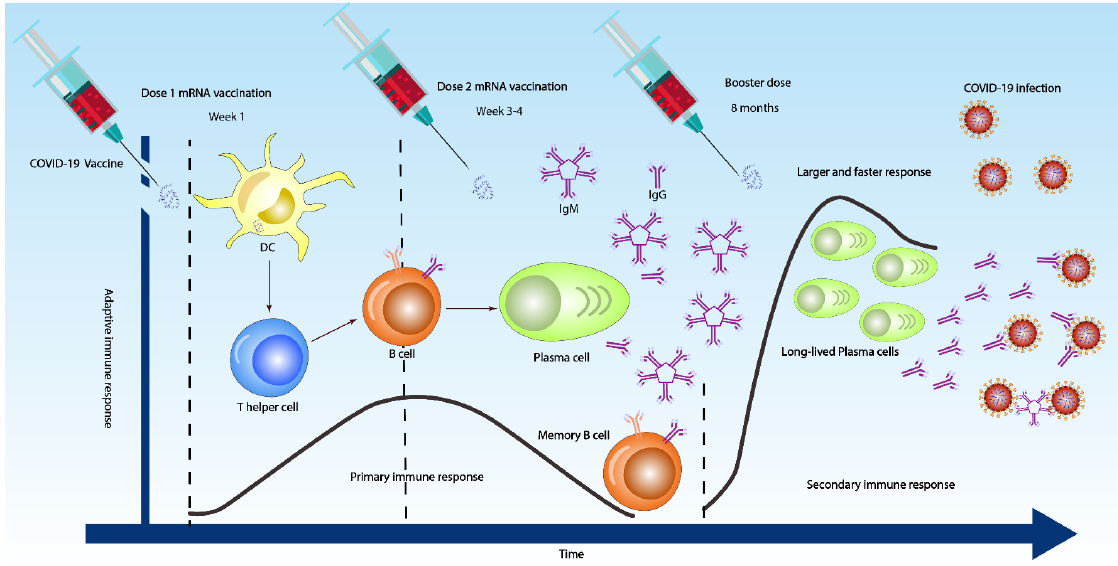
Figure 2. Overall antibody responses to 3 COVID-19 doses. After the first dose (sometimes IgM and IgG are detected as early as day 4 or 5 in week one), the dendritic cell (DC) in the body activates both T cells to differentiate into T helper 2 (Th2) cells and naïve B cell to differentiate into plasma cells. After the second dose at 3–4 weeks, the immune response becomes stronger and faster (primary immune response), producing high IgM and low IgG antibodies. However, booster vaccine injection might induce a very strong and vigorous immune response, with long-lived plasma cells producing low IgM and high IgG antibodies that may effectively opsonize, neutralizing the SARS-CoV-2 viruses (secondary immune response).